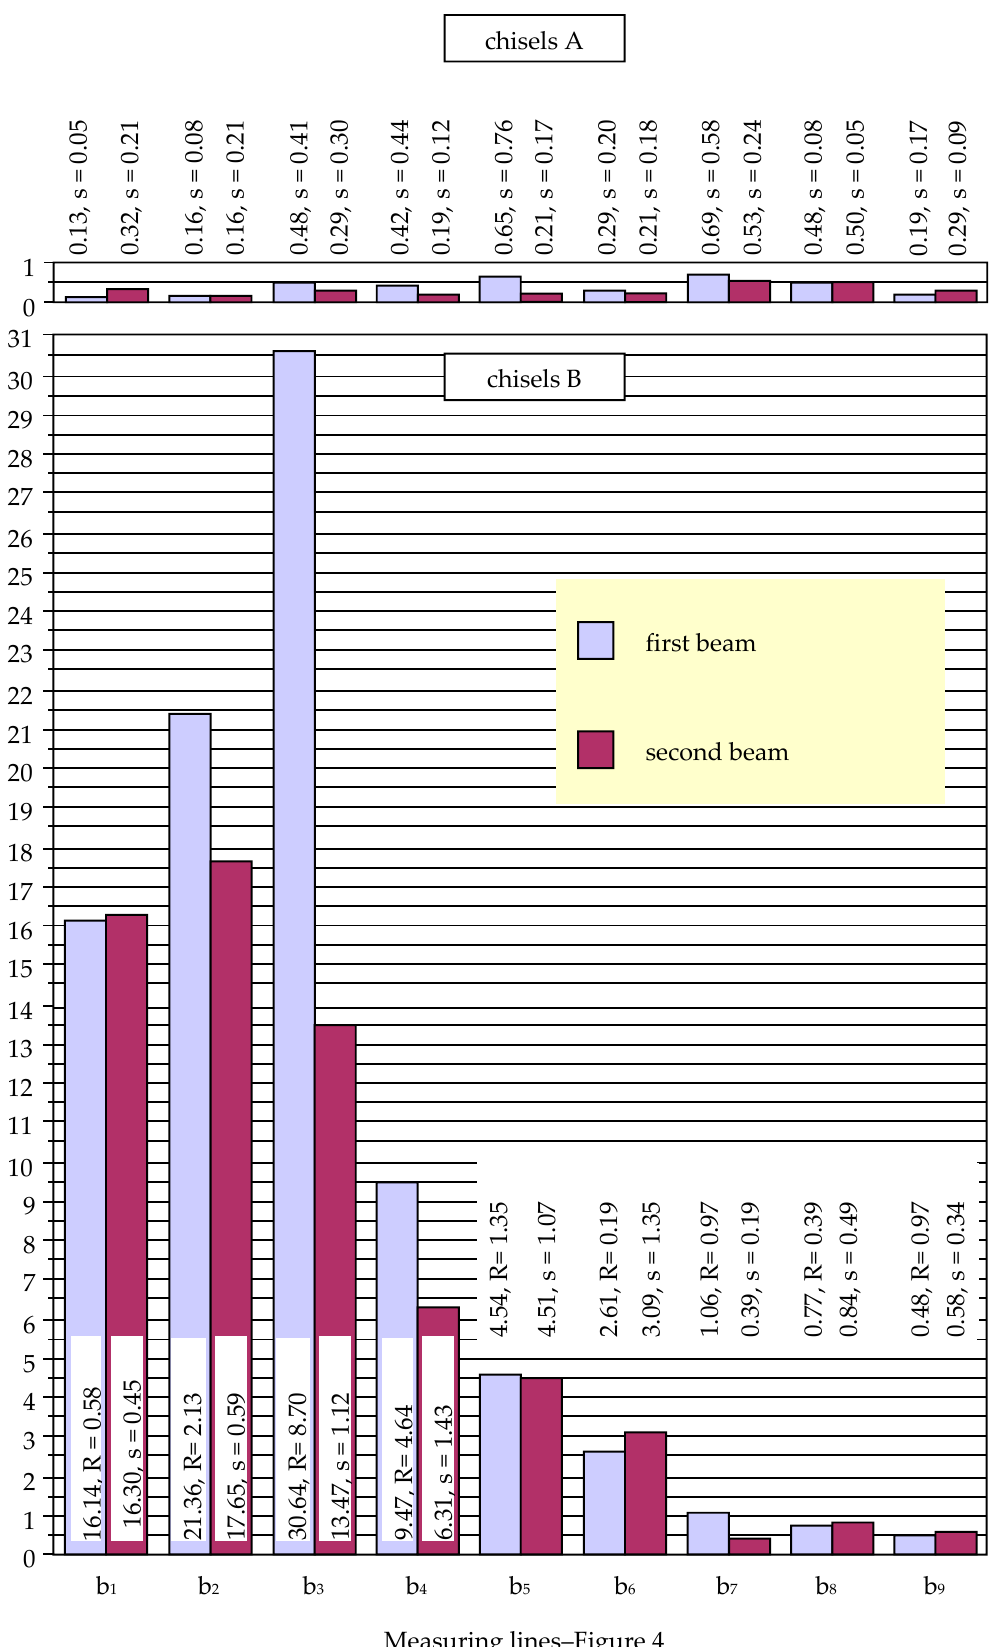
Figure 11. Unit width loss of chisels A and B (s, standard deviation; R, range).